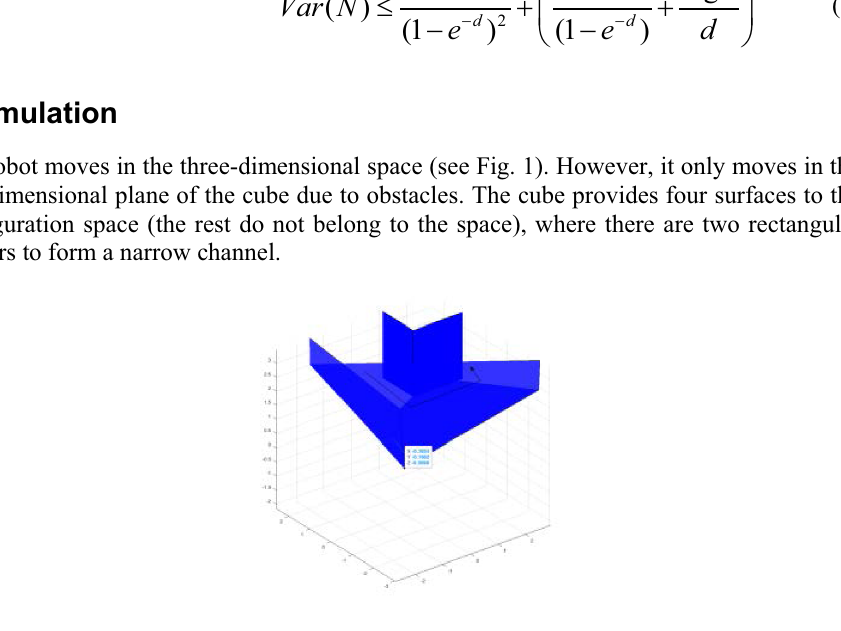
Fig. 1. 3D motion space of the robot.